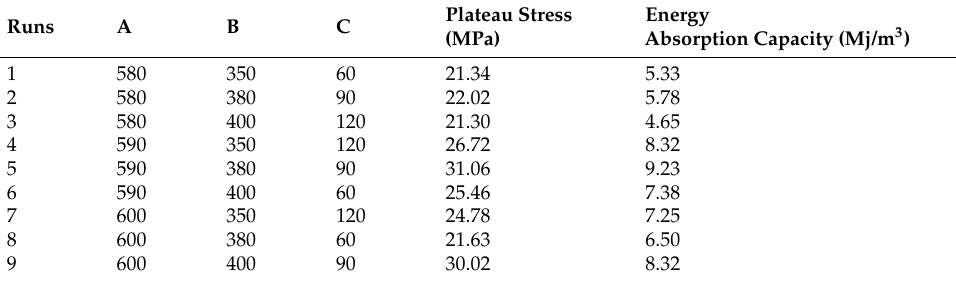
Table 4. L 9 orthogonal array layout with design